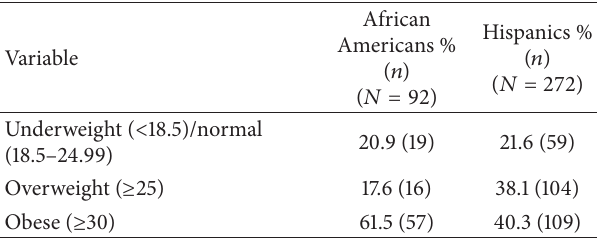
Table 4: BMI classifications of African American and Hispanic